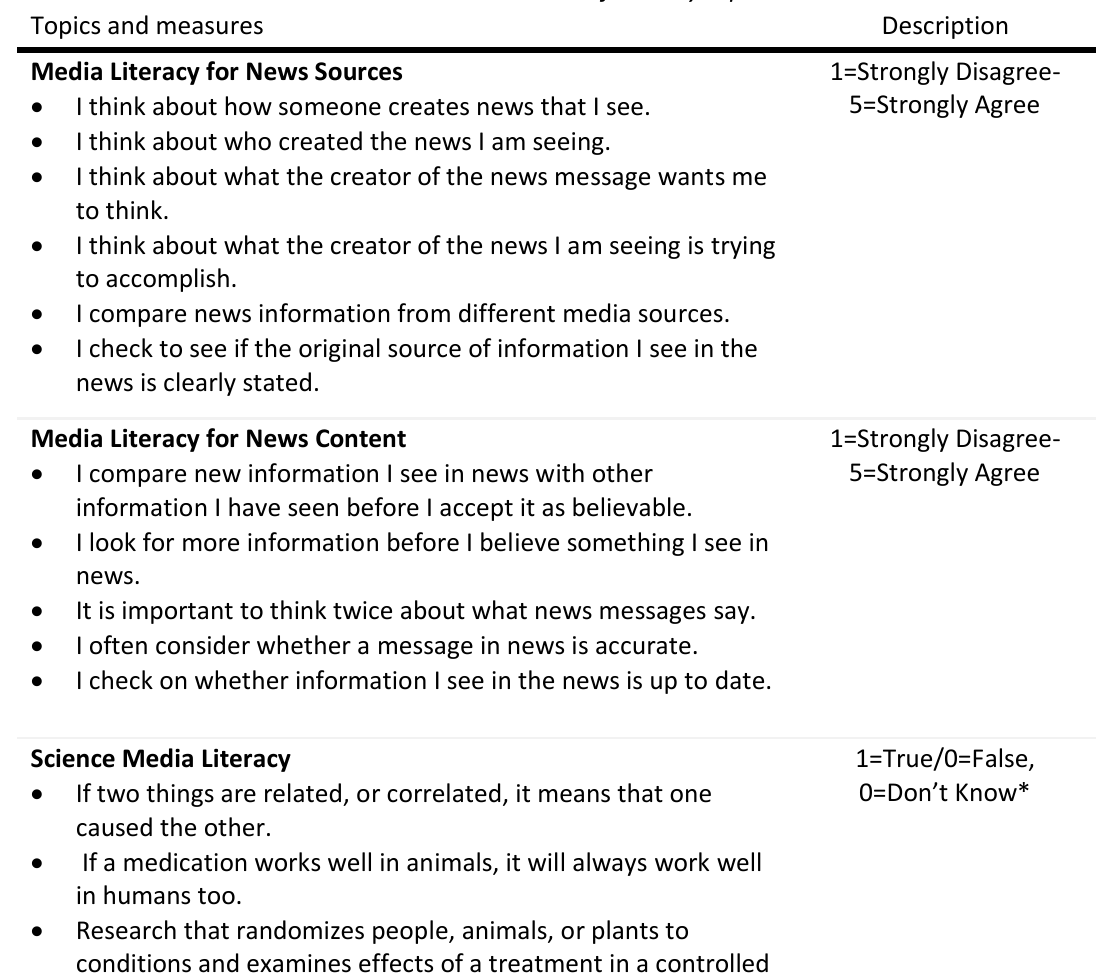
Table 4. Measures for study